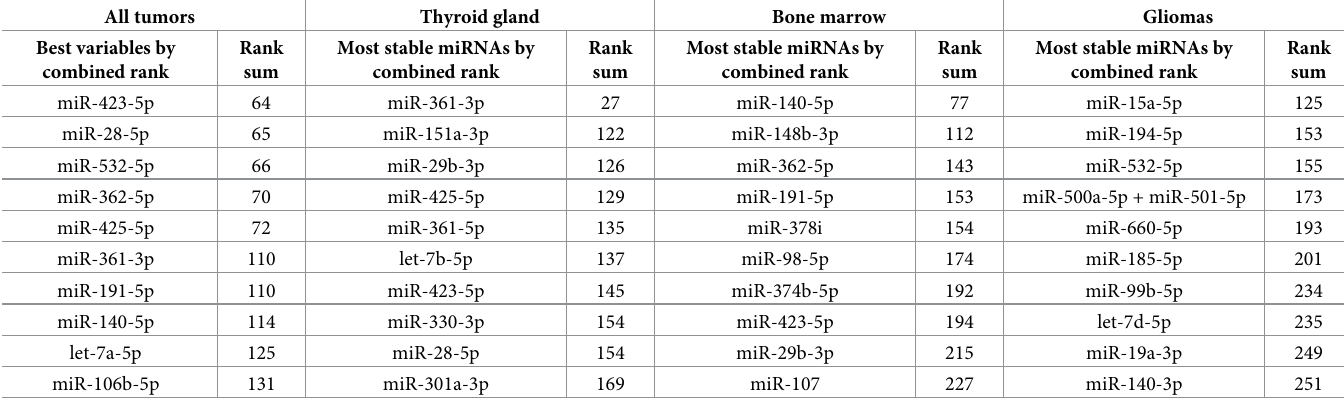
Table 1. MicroRNAs with the most stable expression in different tissues according to NanoString data. All tumors